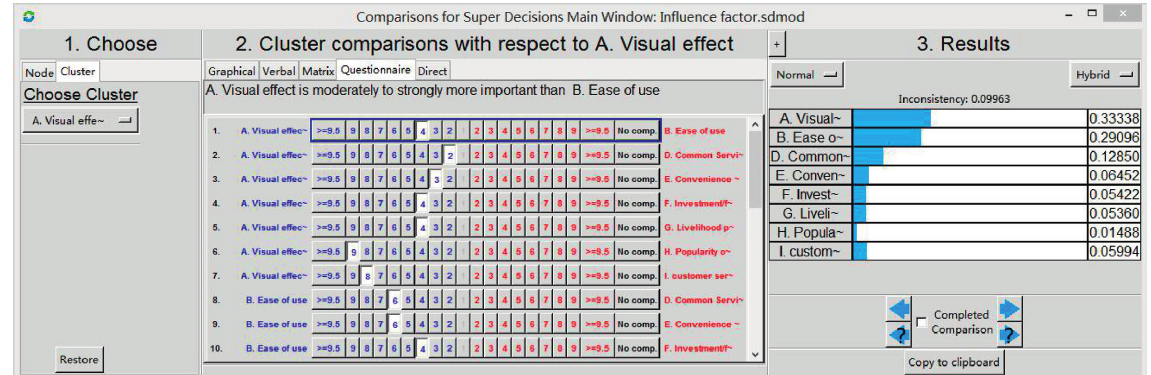
Figure 4: Display of the normalized weight vector and consistency index.